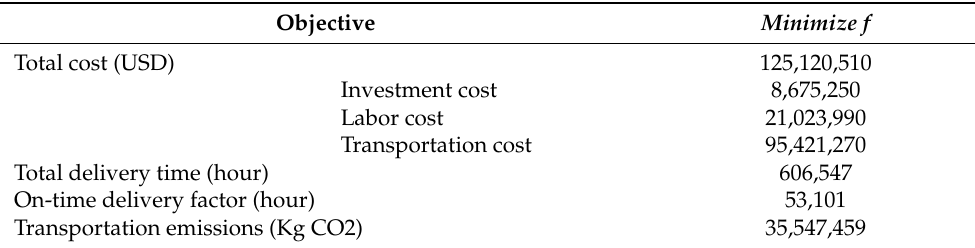
Table 10. Multiple objective optimization result.